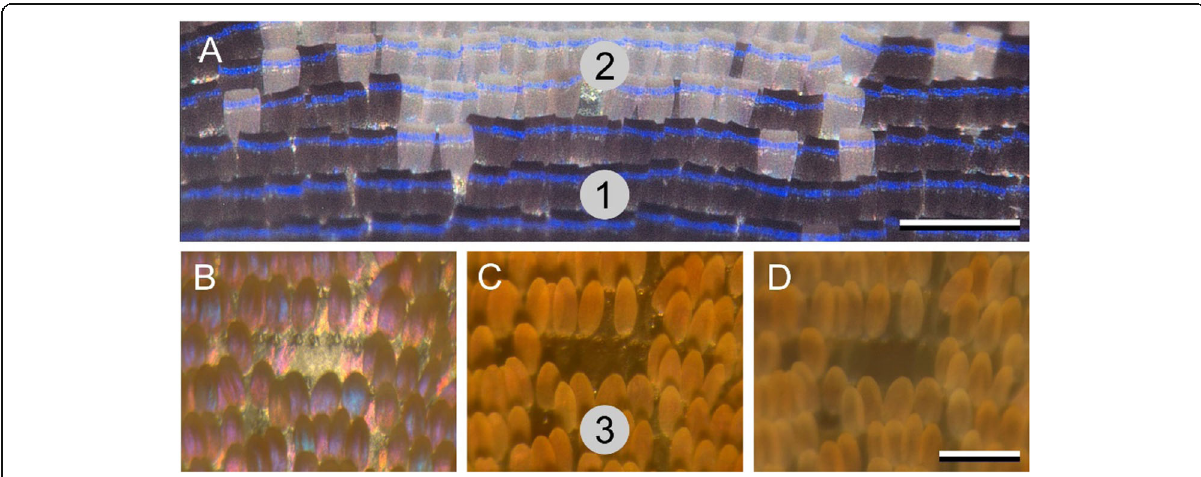
Fig. 4 The lattice of scales on the wing. a Epi-illumination of the transition area of a white spot in the blue area on the dorsal forewing, showing a similar blue stripe on the light- and dark-colored scales. b - d Epi-illumination light micrographs of an orange-yellow wing area on the dorsal forewing, with a few missing scales in the center. b Normal illumination with linearly polarized light (parallel polarizer and analyzer). c Idem with a crossed polarizer and analyzer. d Oblique illumination (~ 45°) with unpolarized light. The numbers 1 – 3 in a and c correspond to the numbered areas in Fig. 1b, e. Scale bars a-d : 200 μ